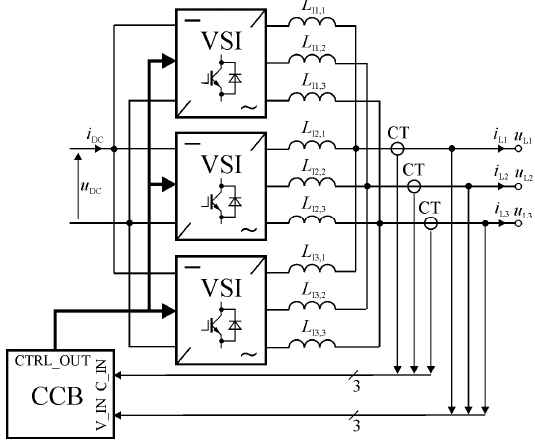
Figure 5. Block diagram of the power grid side converter. CCB, control block; VSI, voltage source inverter.